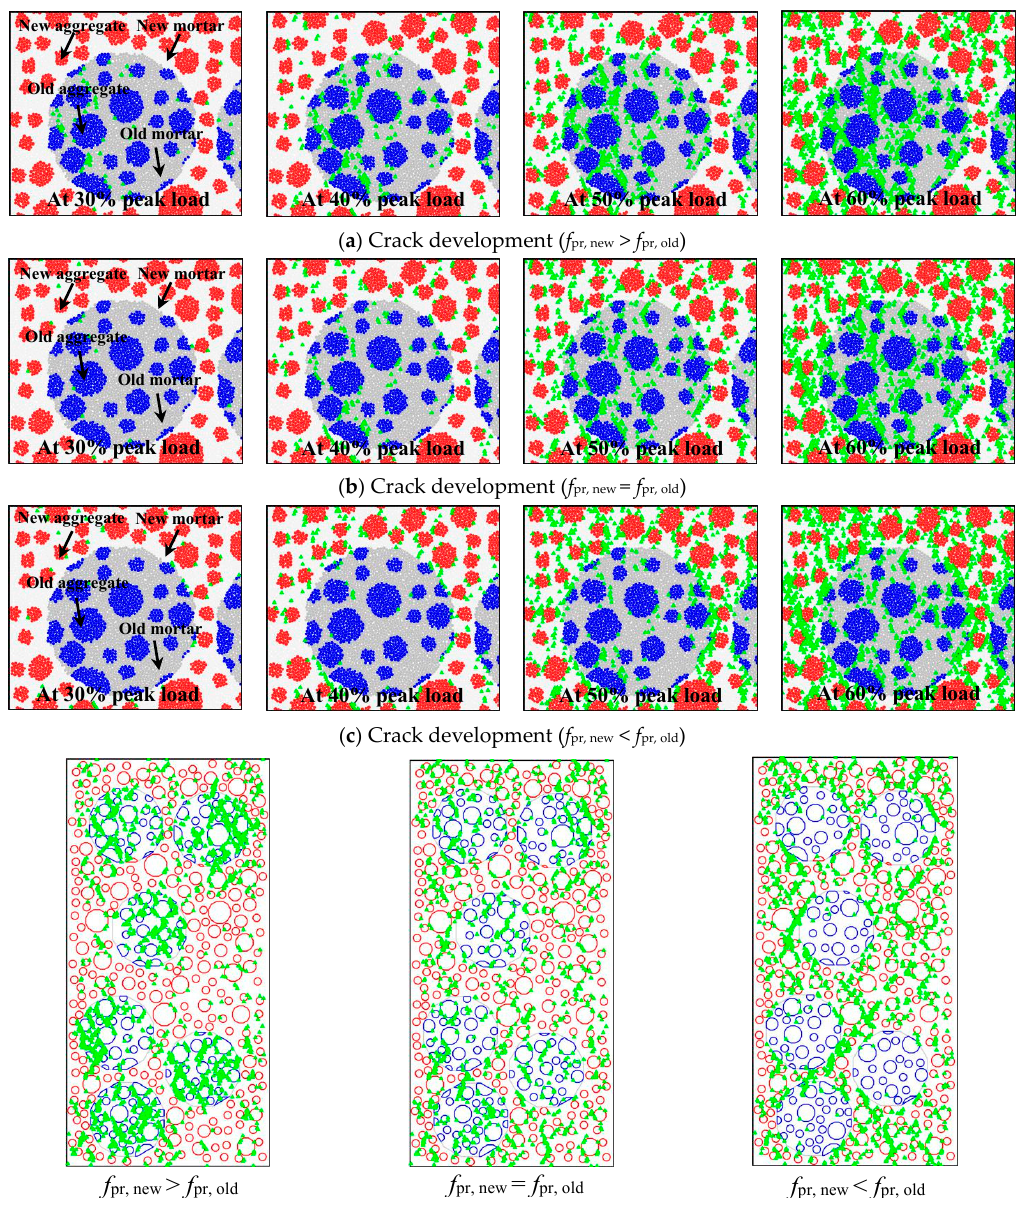
Figure 10. Crack development in recycled lump concrete.